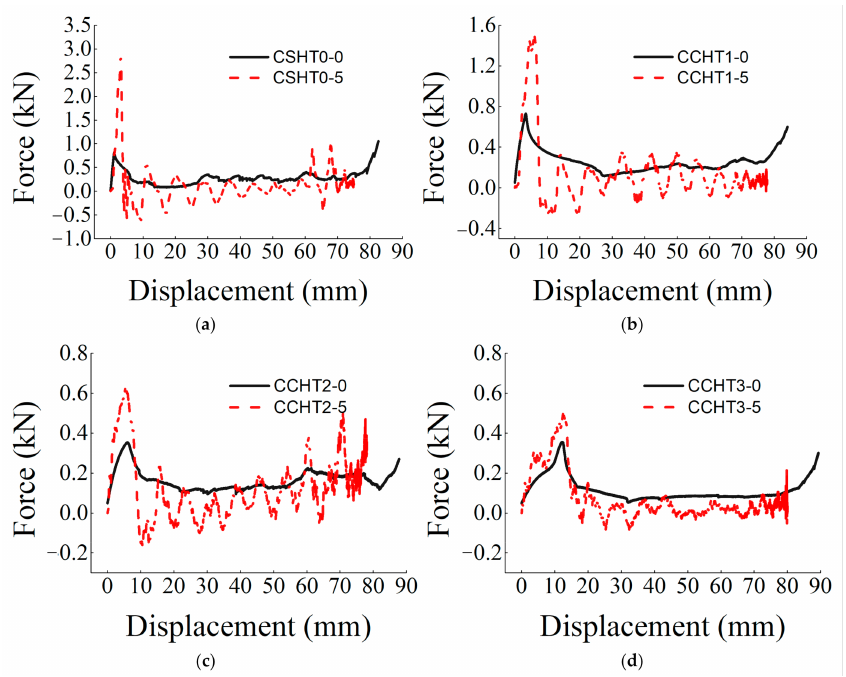
Figure 13. Comparison of the force–displacement curves under quasi static and dynamic conditions: ( a ) CSHT0, ( b ) CCHT1, ( c ) CCHT2, and ( d )